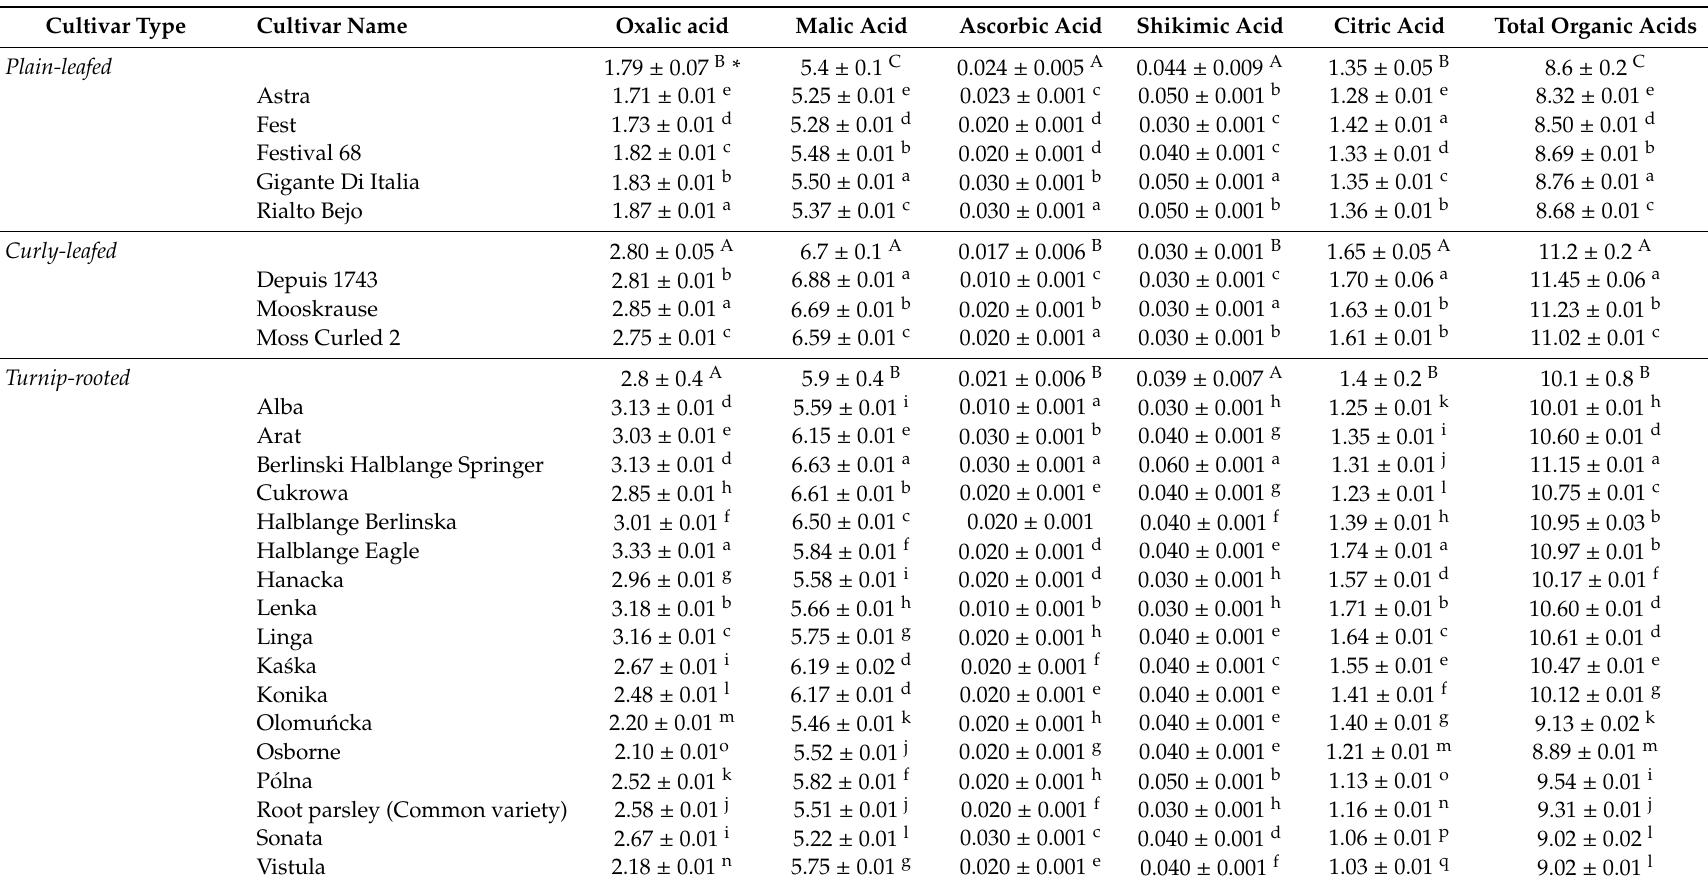
Table 3. Organic acids composition (mg / 100 g dw) of the studied parsley leaf samples (mean ±